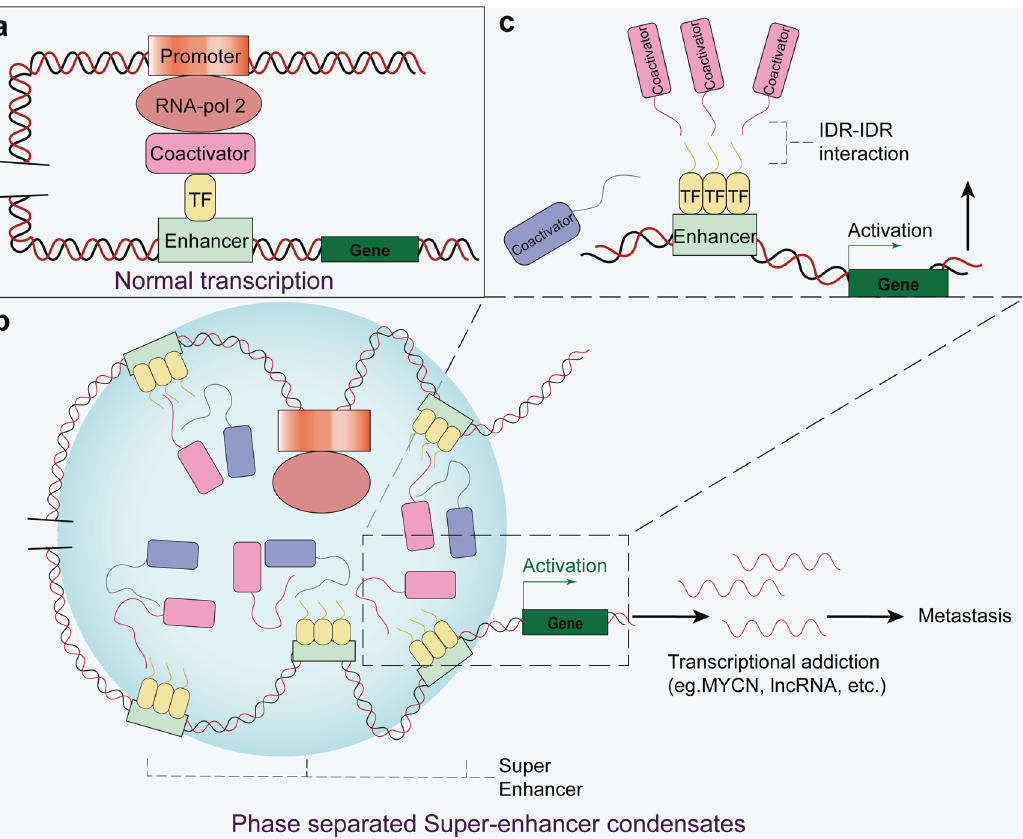
Fig. 5 Components and processes in normal transcription and SE-mediated transcriptional addiction of genes in cancer. a The normal transcription of a gene involves proper interactions among the promoter, RNA pol 2, coactivators, TFs and enhancers. b The SE condensates form a liquid-like complex via LLPS and may result in the transcriptional addiction of certain genes. c Detailed illustration of the IDR-IDR interaction that promotes SE